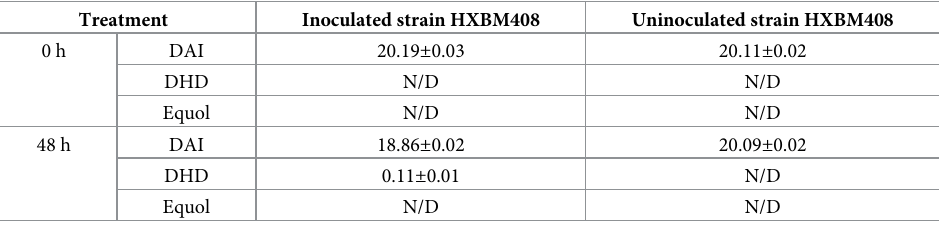
Table 1. Concentration of daidzein and its metabolites in culture medium before and after culture of HXBM408 ( μ g/mL).